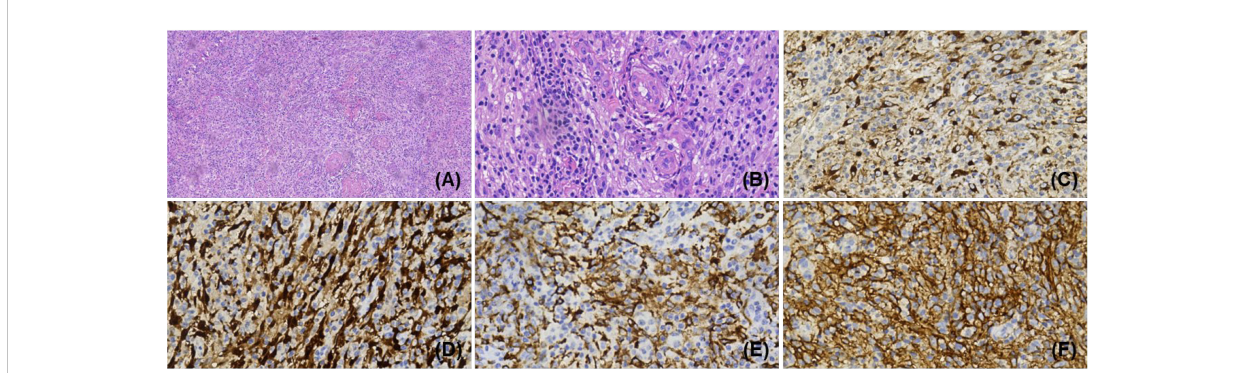
FIGURE 2 Pathologic histology of histiocytic sarcoma. (A) , Structural disruption of the lymph nodes under the microscope, along with marked proliferation of small vessels and a diffuse distribution of cells with slightly larger nuclei and abundant cytoplasm (H&E staining, ×100). (B) , Severe in fl ammatory cell in fi ltration in the alternating bright and dark areas; distribution of lymphocytes and plasma cells around the vessels in a target ring-like pattern (H&E staining, ×400). Immunostaining of tumor cells with positive staining for (C) , CD68 and (D) , S-100, respectively (IHC, × 400). (E) , Membrane staining for the most speci fi c histiocytic marker, CD163 + (IHC, × 400). (F) , Diffuse staining for PD-L1 + in the tumor cells (IHC, × 400).